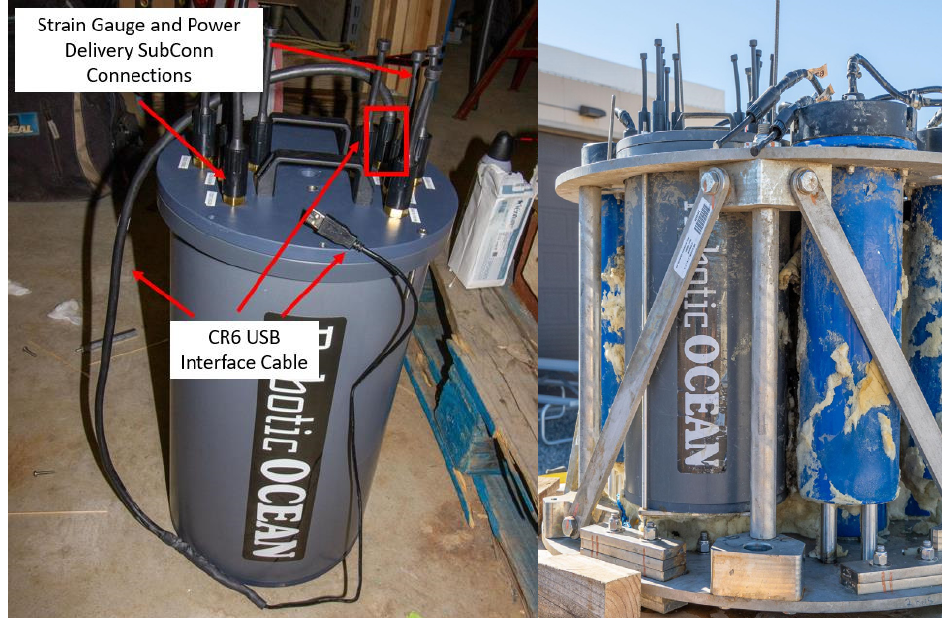
Figure 5. Robotic Ocean DAQ canister ( left ) before deployment and ( right ) after deployment. All seals and the internal vacuum remained intact for the duration of the deployment.